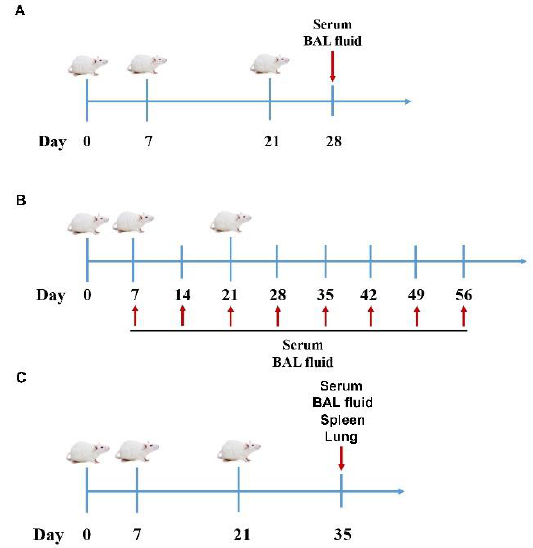
Figure 1. Immunization schemes. ( A ) Vaccination schedule of experiment A. Mice ( n = 6/group) were immunized intranasally on days 0, 7, and 21. On day 28, serum and bronchoalveolar lavage (BAL) fluid were collected for antibody assays. ( B ) Vaccination schedule of experiment B. Mice ( n = 48/group) were immunized intranasally on days 0, 7, and 21. On days 7, 14, 21, 28, 35, 42, 49, and 56, 6 mice were taken out from each group and euthanized. Serum and BAL fluid were collected to detect antibody responses. ( C ) Vaccination schedule of experiment C and D. Mice ( n = 18/group in experiment C, n = 12/group in experiment D) were immunized intranasally on days 0, 7, and 21. On day 35, serum and BAL were collected for determination of IgG isotypes and neutralizing antibody titers; spleens and lungs were harvested for detecting IgA-secreting cells, lymphocyte proliferation, cytokine production, T cell differentiation, and type I interferon signaling activities.